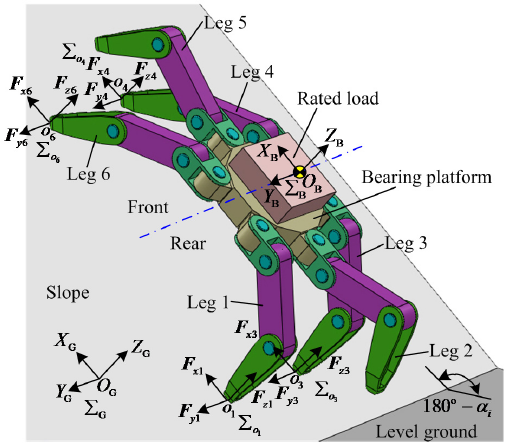
Figure 3. Simplified 3 ‐ D model of robot using crab ‐ type quadrangular gait to pass slope.